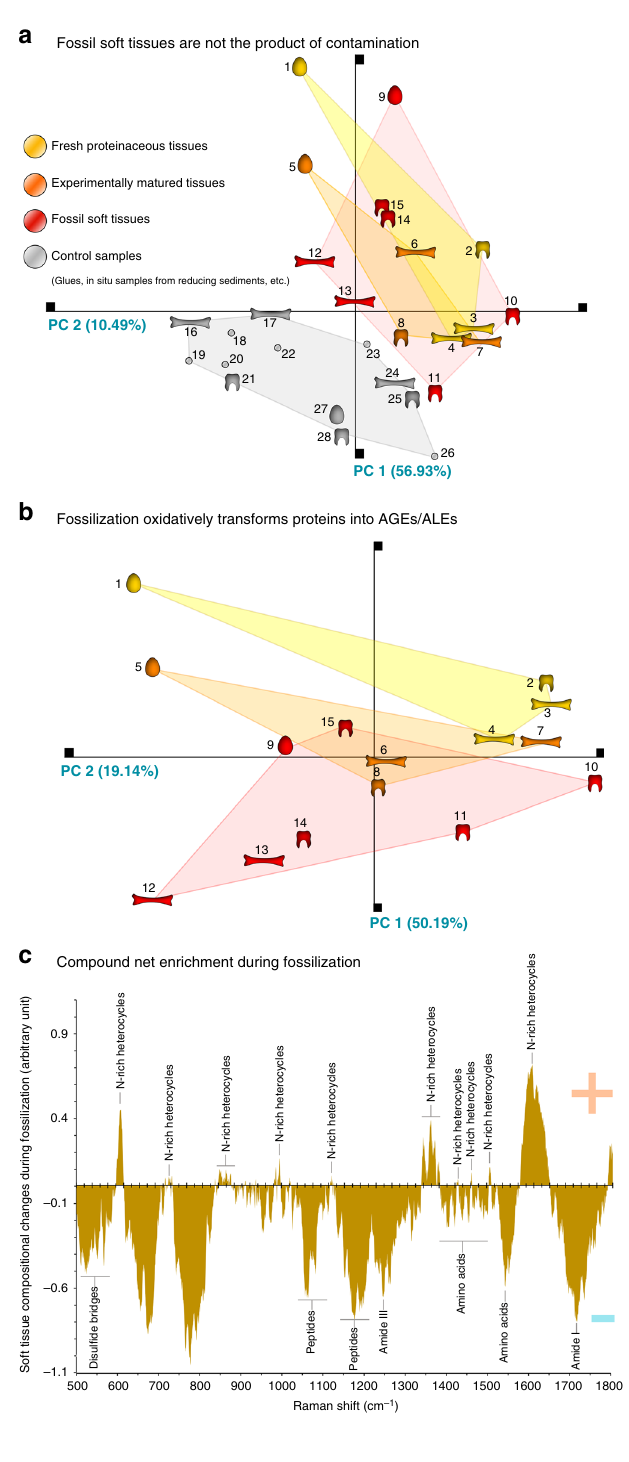
endogenous soft tissues in fossil vertebrate remains as a basis for addressing a range of evolutionary questions.